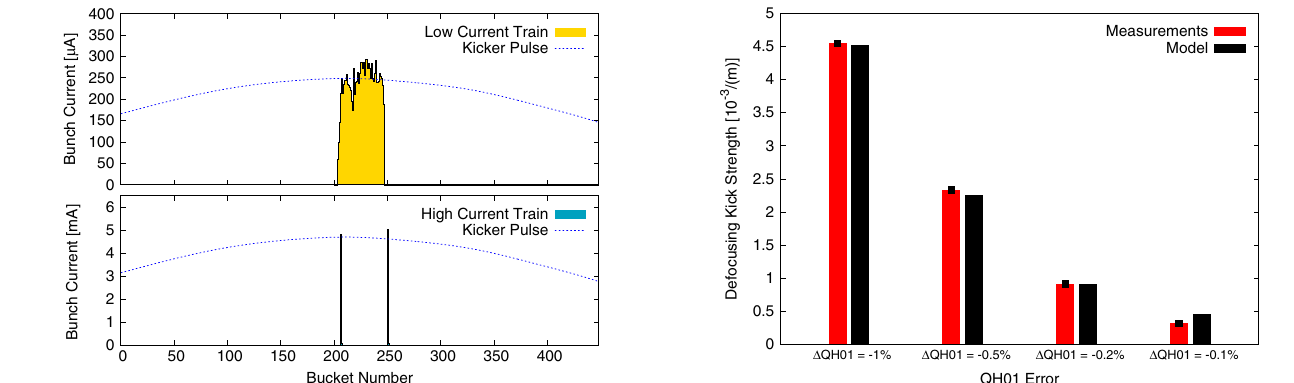
FIG. 5. In red, measured change in the focusing kick for different QH01 setpoints. Each measurement is obtained averag- ing over data sets containing 100 acquisitions each. The error bars represent the standard deviation of the estimated focusing kick due to the acquisition to acquisition fluctuations. In black, the expected kick based on magnetic